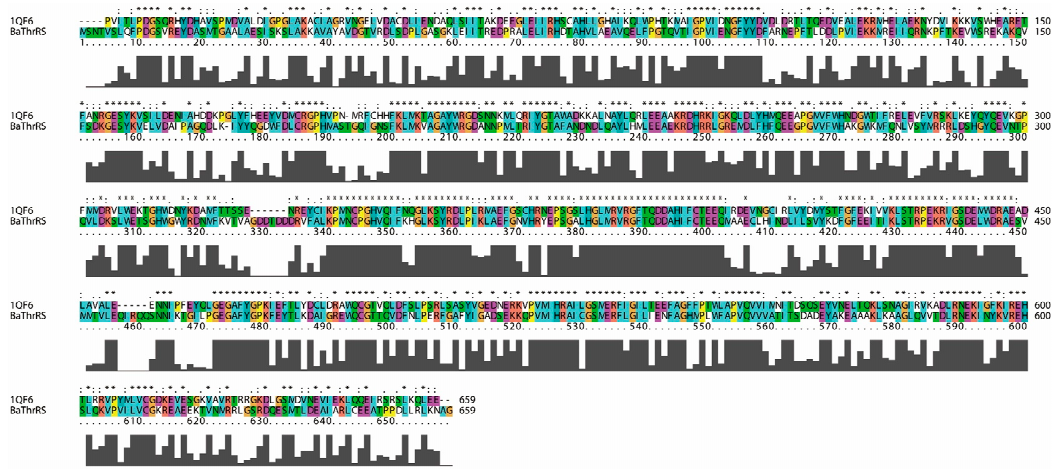
Figure 1. Sequence alignment of threonyl-tRNA synthetases from Brucella abortus (BaThrRS) and Escherichia coli (EThrRS) (sequence identity, 51%).